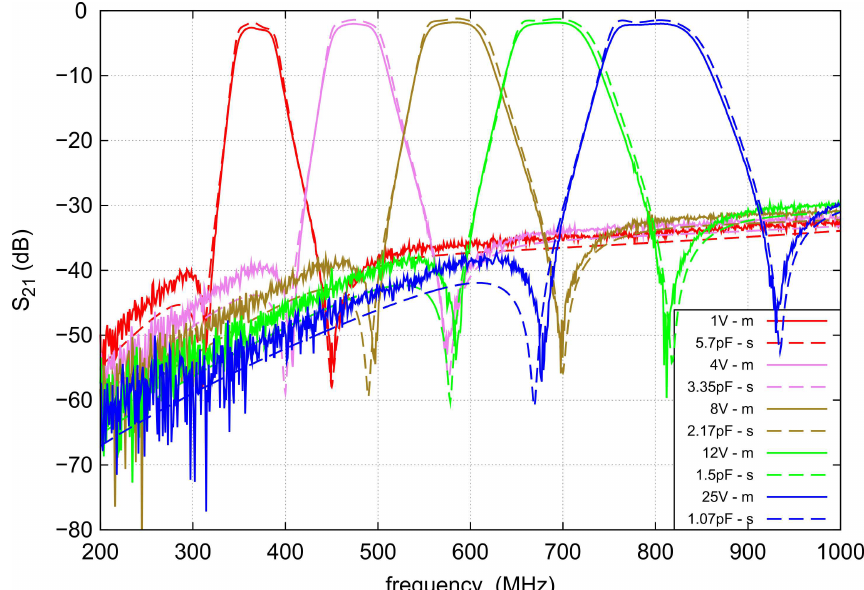
Figure 15. Measured (solid lines) and simulated (dashed lines) s 21 of the proposed tunable bandpass filter for the five selected control voltages.